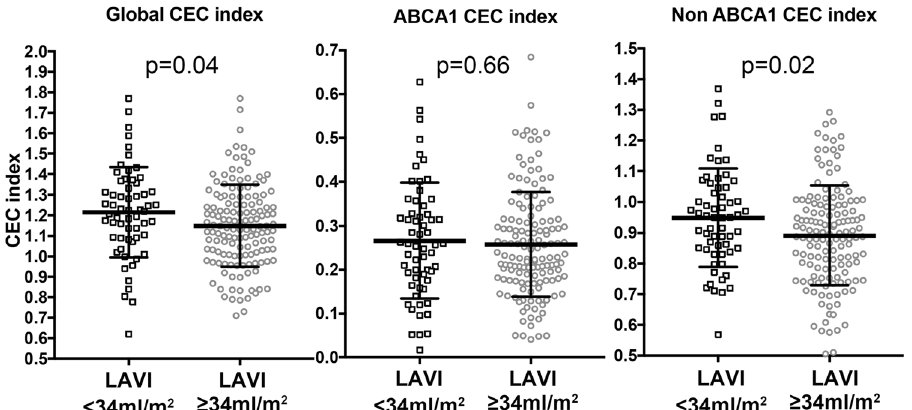
Figure 1. Global CEC, ABCA1 CEC and Non-ABCA1 CEC in patients with and without an enlarged left atrium (LAVI ≥ and < 34 mL/m 2 ). Global CEC, ABCA1 CEC and non-ABCA1 CEC were measured in AF patients with LAVI ≥ and < 34 mL/m 2 . The value was normalized with the respective QC value on each assay plate to calculate the indexed value. Each open square/circle represents one participant. The horizontal lines indicate average ± standard deviation, respectively.